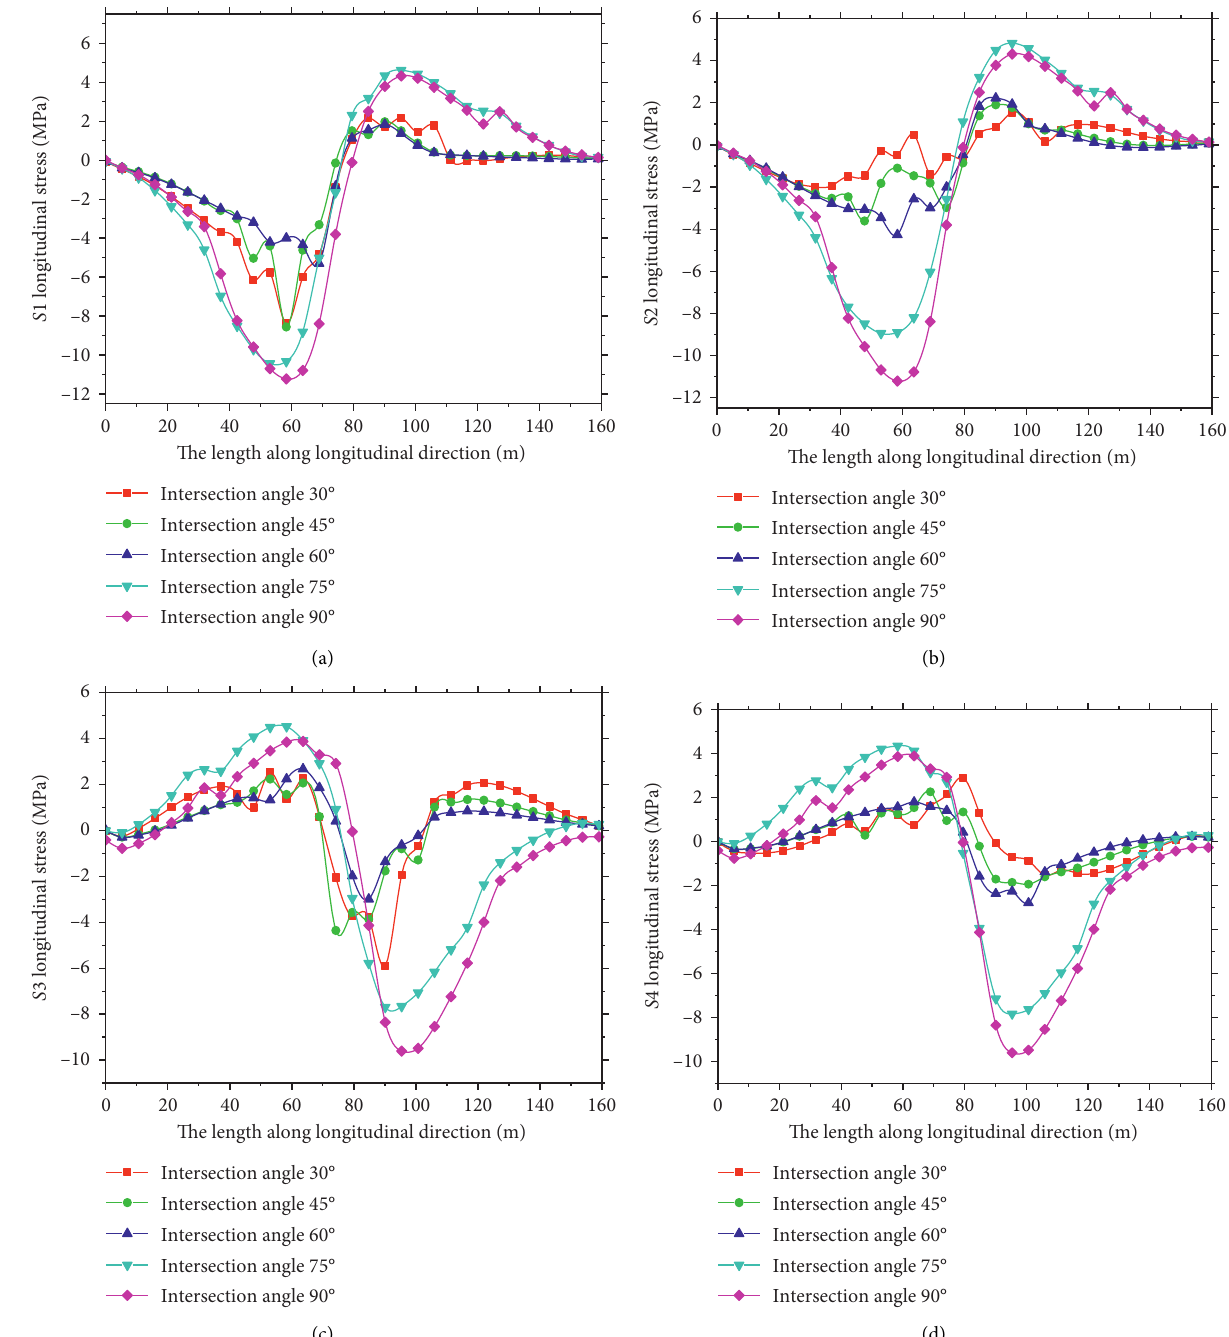
Figure 10: Axial tension stress with different intersection angle. (a) The axial tension stress of surveying line 1. (b) The axial tension stress of surveying line 2. (c) The axial tension stress of surveying line 3. (d) The axial tension stress of surveying line